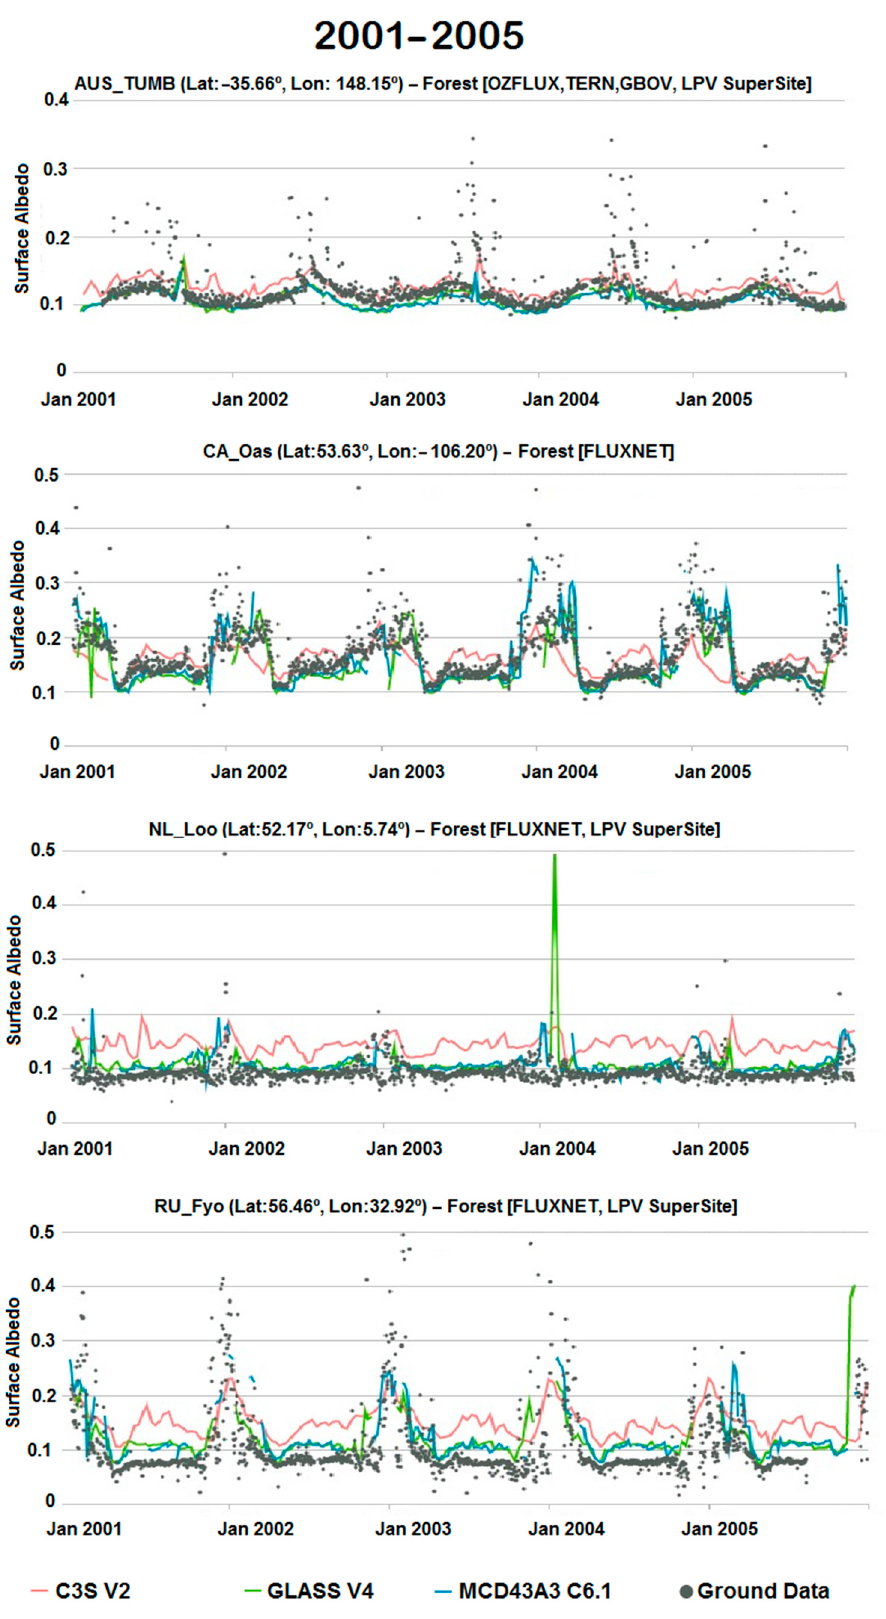
Figure 8. Examples of albedo temporal variations in C3S V2 (red), GLASS V4 (green), and MCD43A3 C6.1 (blue) satellite products (all quality pixels not just high quality) and ground data (black dots) from 4 REALS sites during the 2001–2005 period.